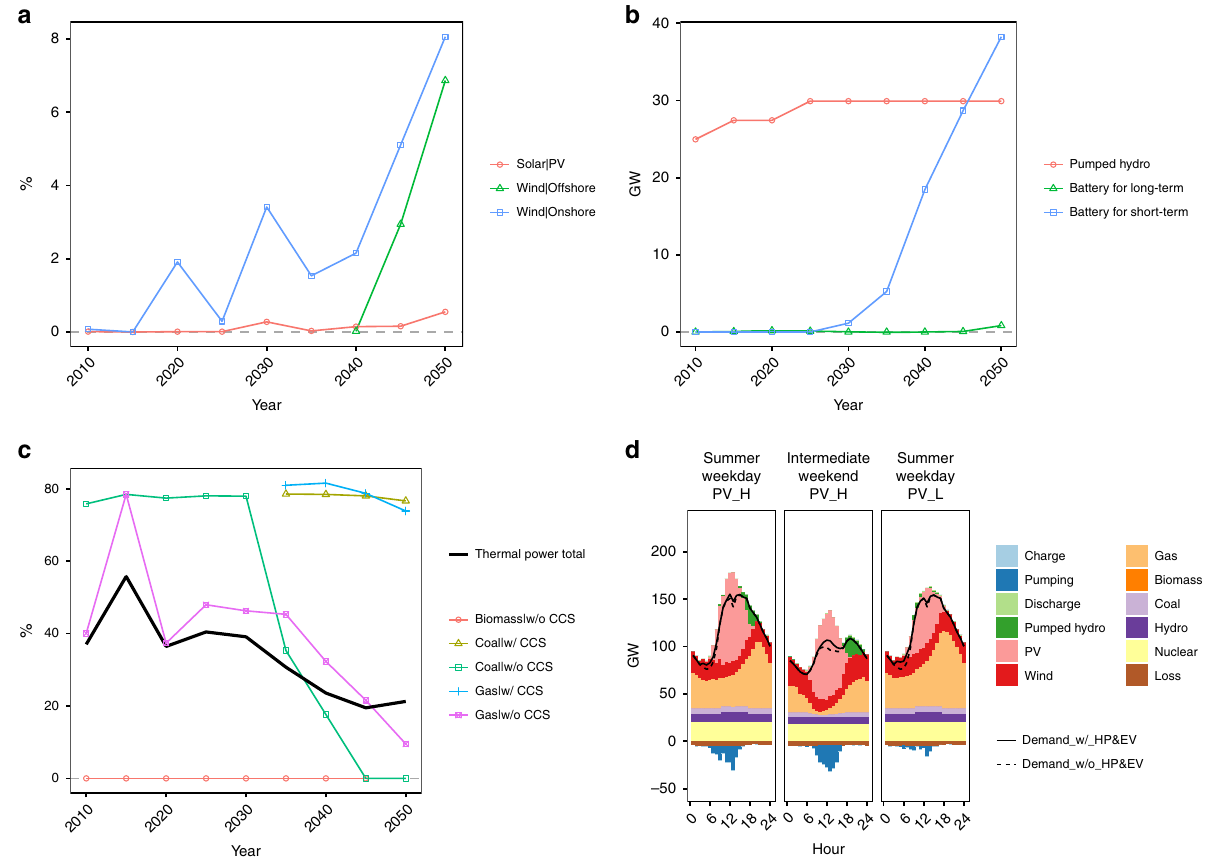
Fig. 2 Power system reactions to large-scale renewable energy penetration. a Wind and solar curtailment rate, which is the unused energy divided by total power generation for each energy source, b the installed capacity of technologies to stabilise fl uctuations in the electricity supply, c the capacity factor of thermal power, and d the pro fi les of electricity demand and supply on selected three typical days (PV_H and PV_L indicate sunny and cloudy days,